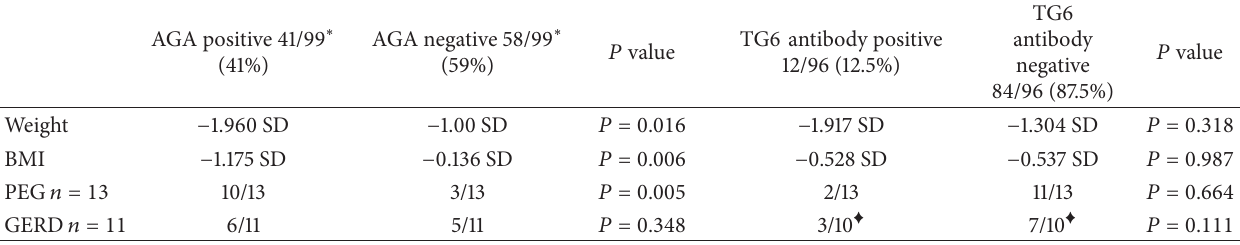
Table 2: Correlation between indicators of feeding problems and immunity to TG6 and to AGA analysed previously ( 𝑛 = 99 ) ∗